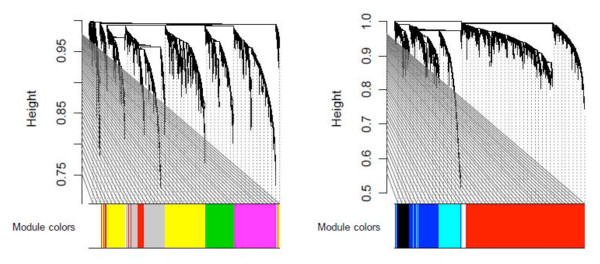
Hierarchical cluster trees for detecting modules based on weighted gene co-expression network analysis. All array samples (primary Sjögren's syndrome patients, sicca, and controls) were to find co-expression modules. Modules correspond to branches of the trees and are assigned color categories as indicated by the color band underneath each tree (see Materials and methods). The two panels correspond to two cluster trees resulting from the blockwiseModules WGCNA R function [21], which was used to circumvent computational challenges. Each cluster tree thus corresponds to a block of genes.